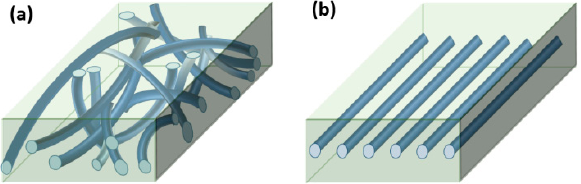
Figure 4. Specimens for testing, ( a ) e-PP/R-HAS and e-PP/randomly distributed HP (R-HP) microfibers for extensional/shear rheometry and foaming and ( b ) e-PP/linearly distributed HAS (L- HAS) and e-PP/linearly distributed HP (L-HP) microfibers along the extensional axis for extensional rheometry. The microfibers are drawn larger than their actual sizes. (Color should be used).